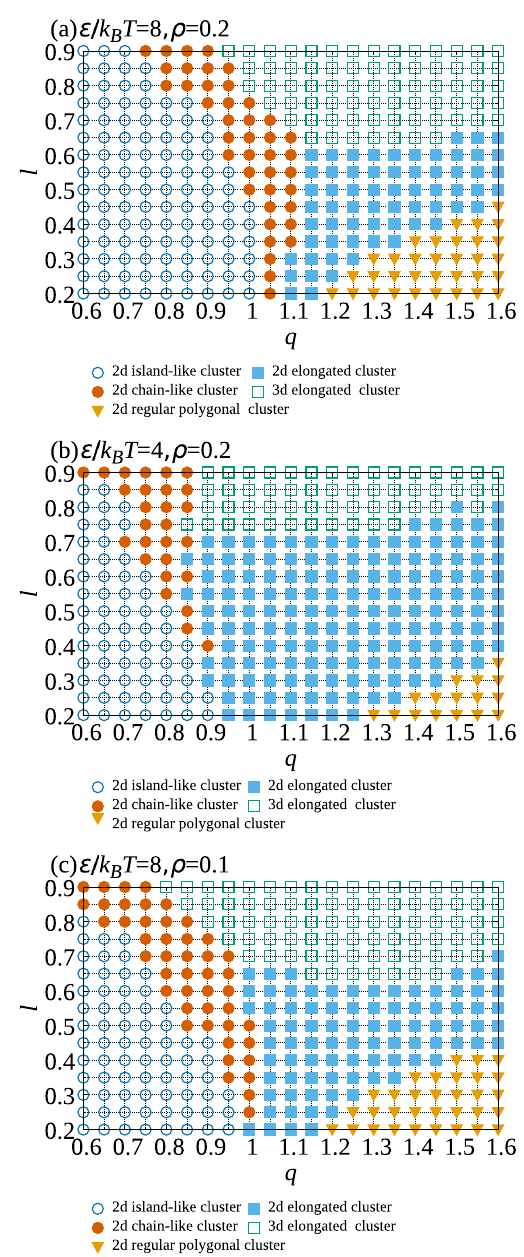
Figure 7. Dependence of cluster type on q and l for ( ǫ/ k B T , ρ)